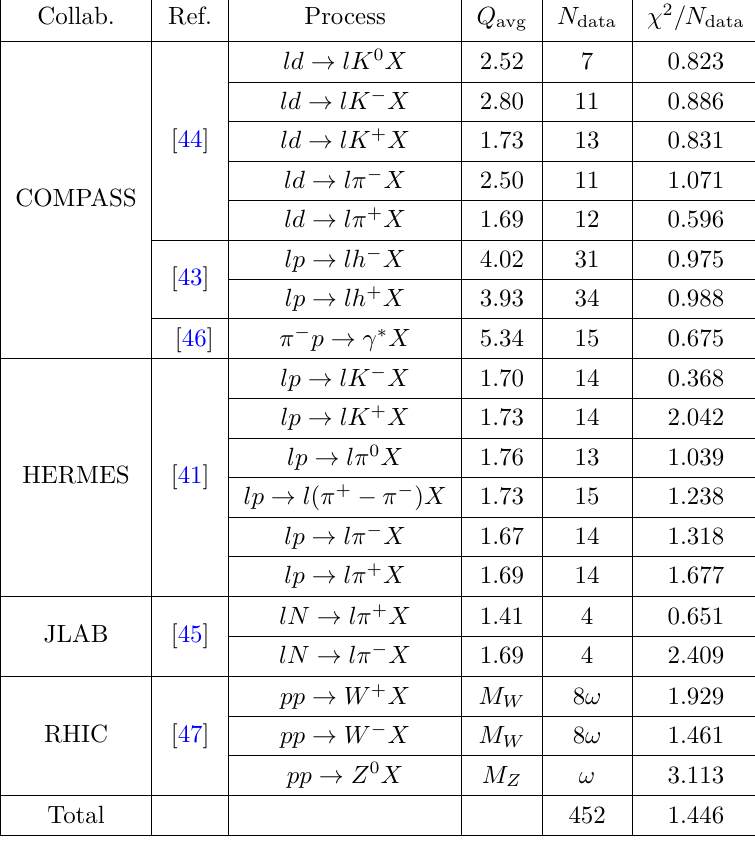
Table 5 . The distribution of χ 2 for each data set for the fit